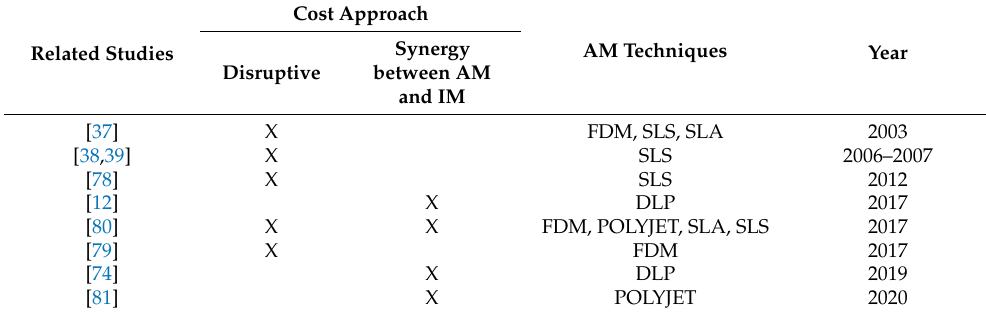
Table 4. Summary of studies into cost models of AM as a disruptive and complementary to IM. Related